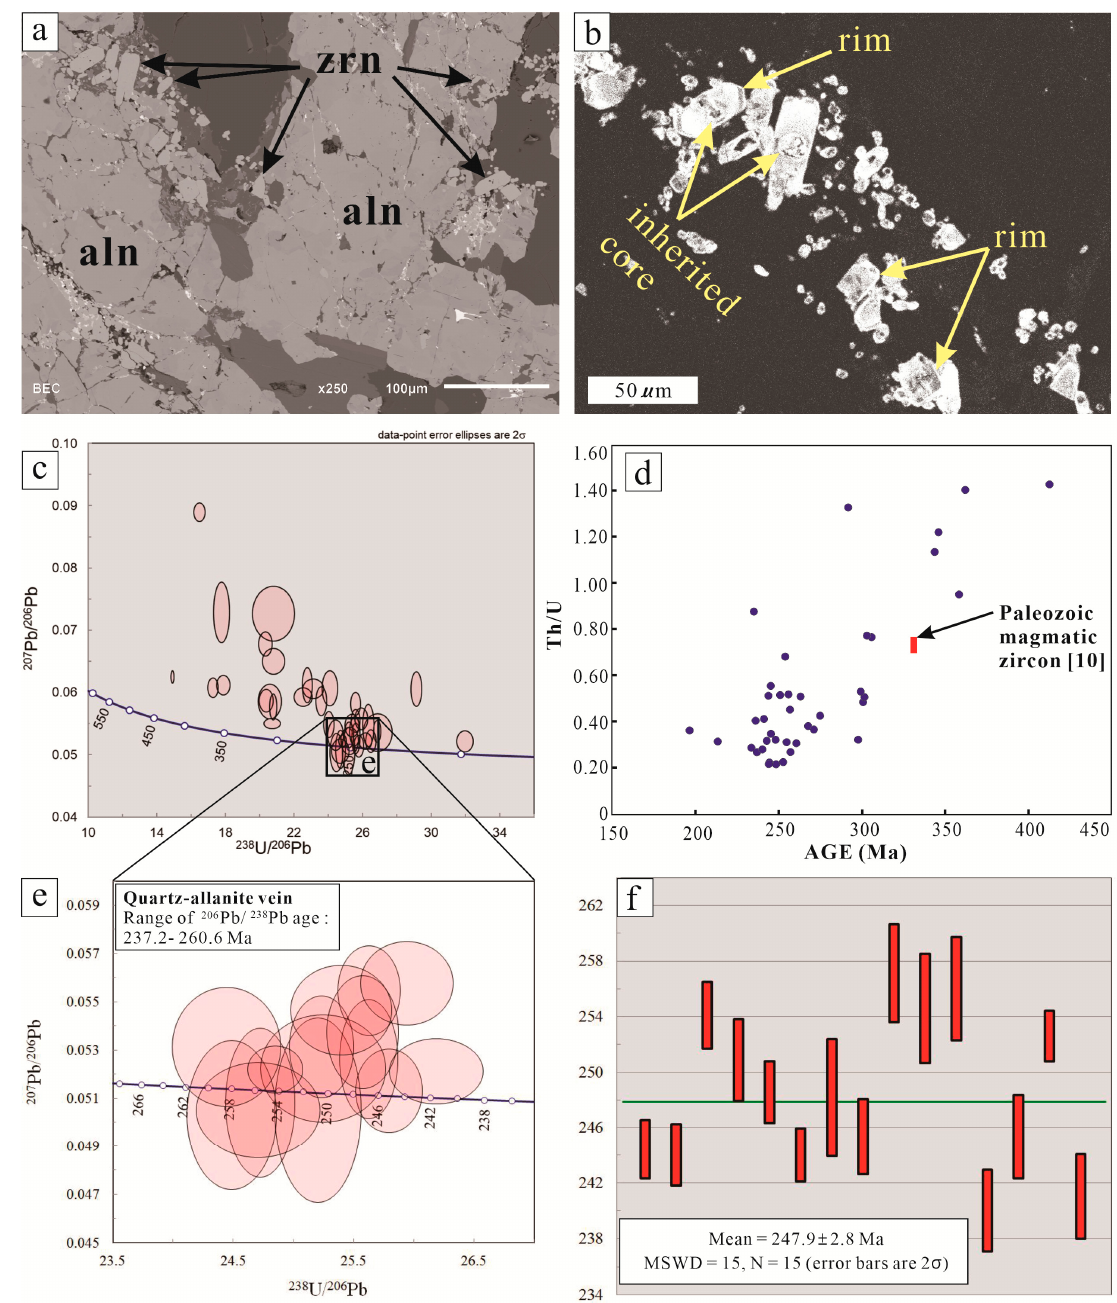
Figure 4. U–Pb isotope analyses. ( a ) Back-scattered electron (BSE) image of zircon from the zircon–allanite vien. ( b ) Cathodoluminescence (CL) image of the euhedral microcrystalline zircon. Note that some zircons have an inherited core and oscillatory zoning. ( c ) Tera–Wasserburg Concordia diagram (all data). ( d ) Age versus Th/U ratio scatter plot (all data; forty). ( e ) Tera–Wasserburg Concordia diagram (selected data; fifteen). ( f ) Weighted average zircon U–Pb ages of the quartz–allanite vein. Table 1. Laser ablation multi-collector inductively coupled plasma mass spectrometry (LA-MC-ICP- MS) U–Pb–Th isotopic analytical data for zircon from the quartz–allanite vein. Anderson Correction Non Correction Ratio